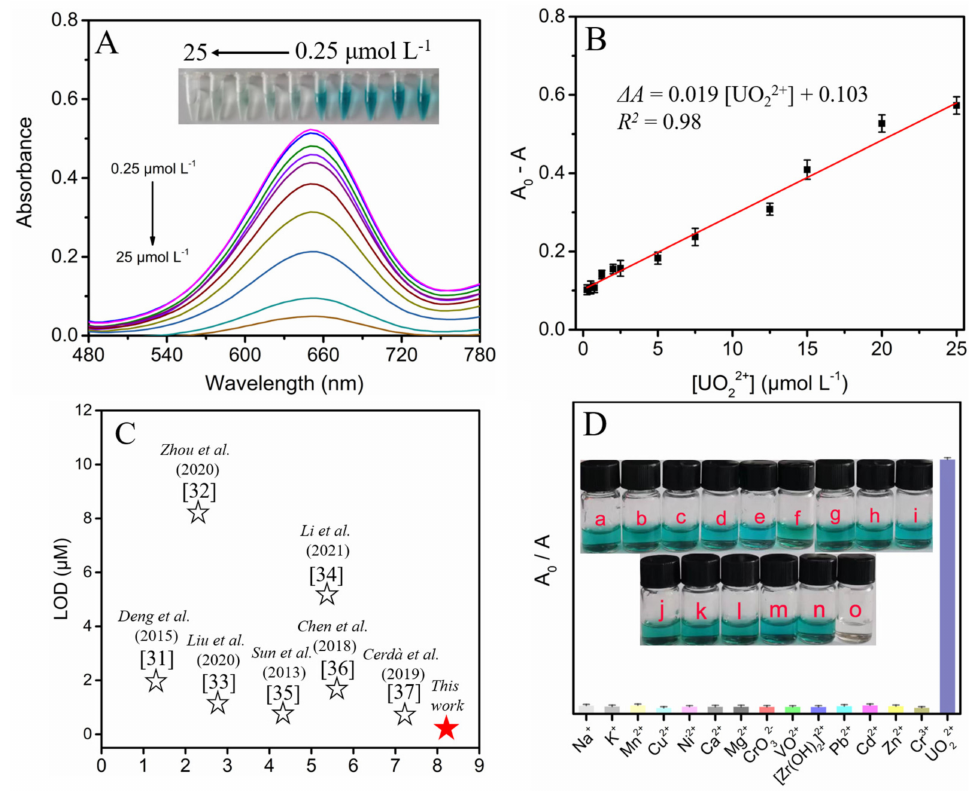
Figure 4. ( A ) UV-vis spectra of TAS-COF + TMB system with different UO 22+ content under visible light irradiation. Insert: the images of the corresponding solutions. ( B ) The linear relationship between the absorbance (A 0 − A) and UO 22+ concentration. ( C ) Comparison of the analytical perfor- mance for UO 22+ assay (Refs. [31–37]). ( D ) Absorbance (A 0 /A, in which A 0 and A represented the absorbance at 650 nm with/without the presence of UO 22+ ) intensity of the system after the addition of UO 2 2+ and different cations. Insets show the images of the corresponding solutions. The error bars were estimated from triplicate measurements ( n =